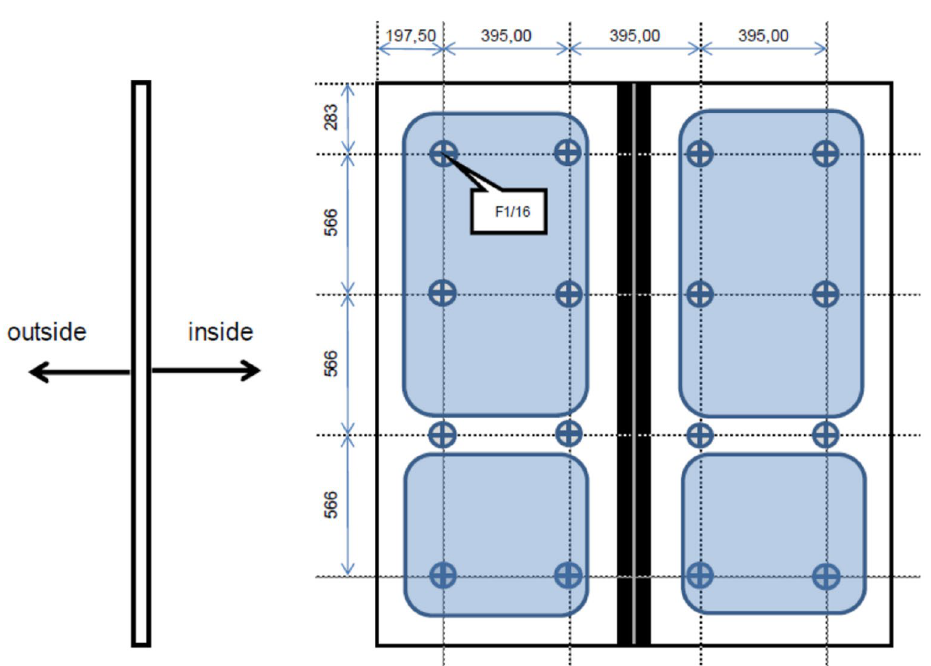
Figure 21. Location of loading during dynamic